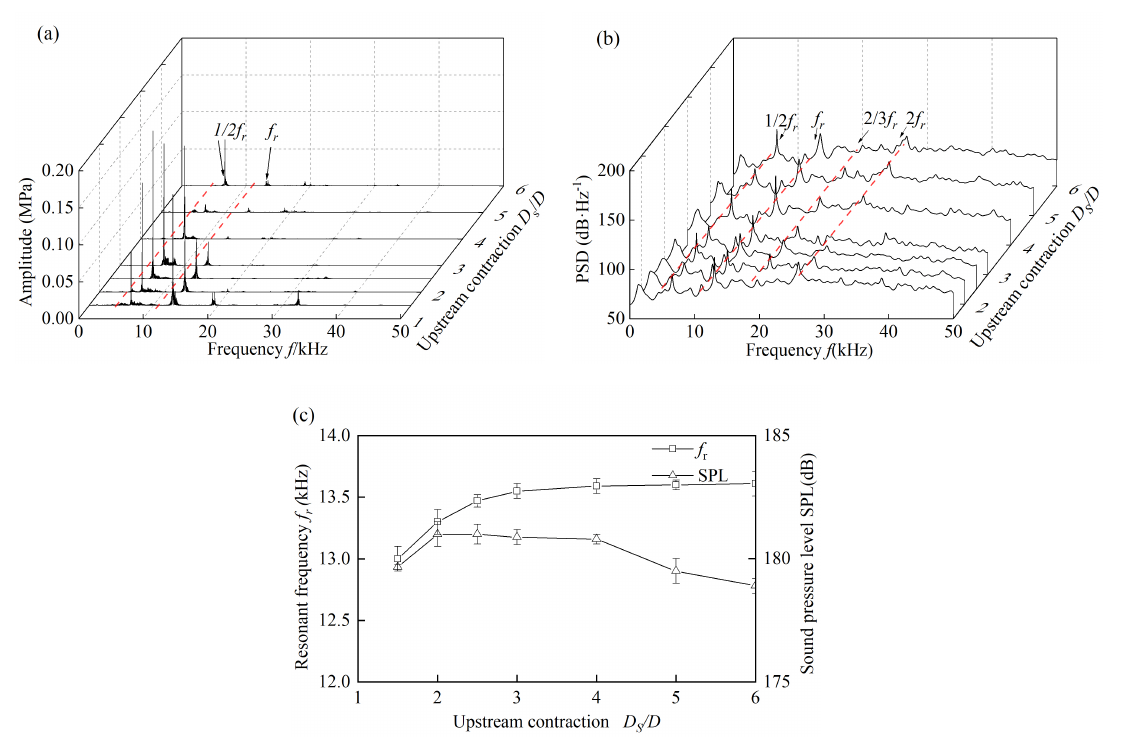
Figure 5. Frequency characteristics of self-excited waterjet as a function of upstream contraction ratio D s / D . ( a ) Spectra of self-excited waterjet’s pressure fluctuation with D s / D from 1.5 to 6; ( b ) power spectrum density of self-excited waterjet’s noise with D s / D from 1.5 to 6; ( c ) resonance frequency and sound pressure level (SPL) as a function of upstream contraction ratio D s / D